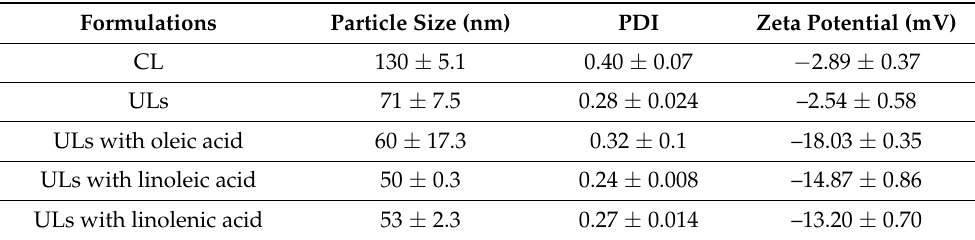
Table 2. The average particle size, polydispersity index (PDI), and zeta potential of various rosmarinic acid-loaded